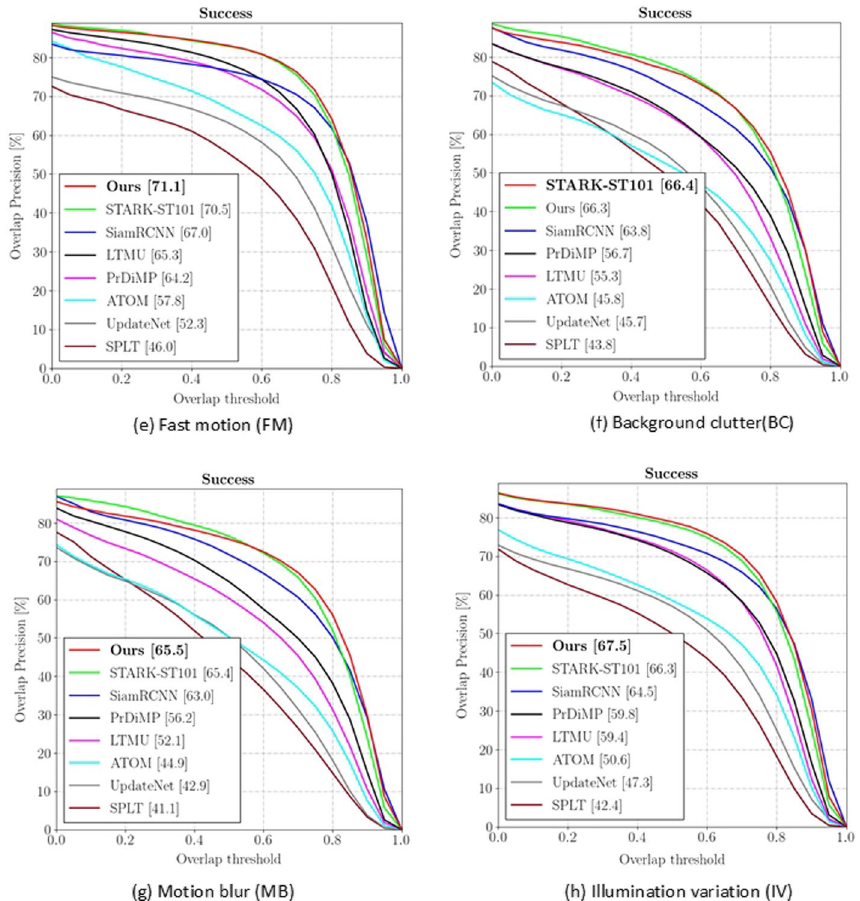
Fig. 7 The success rate of different attributes on the LaSOT